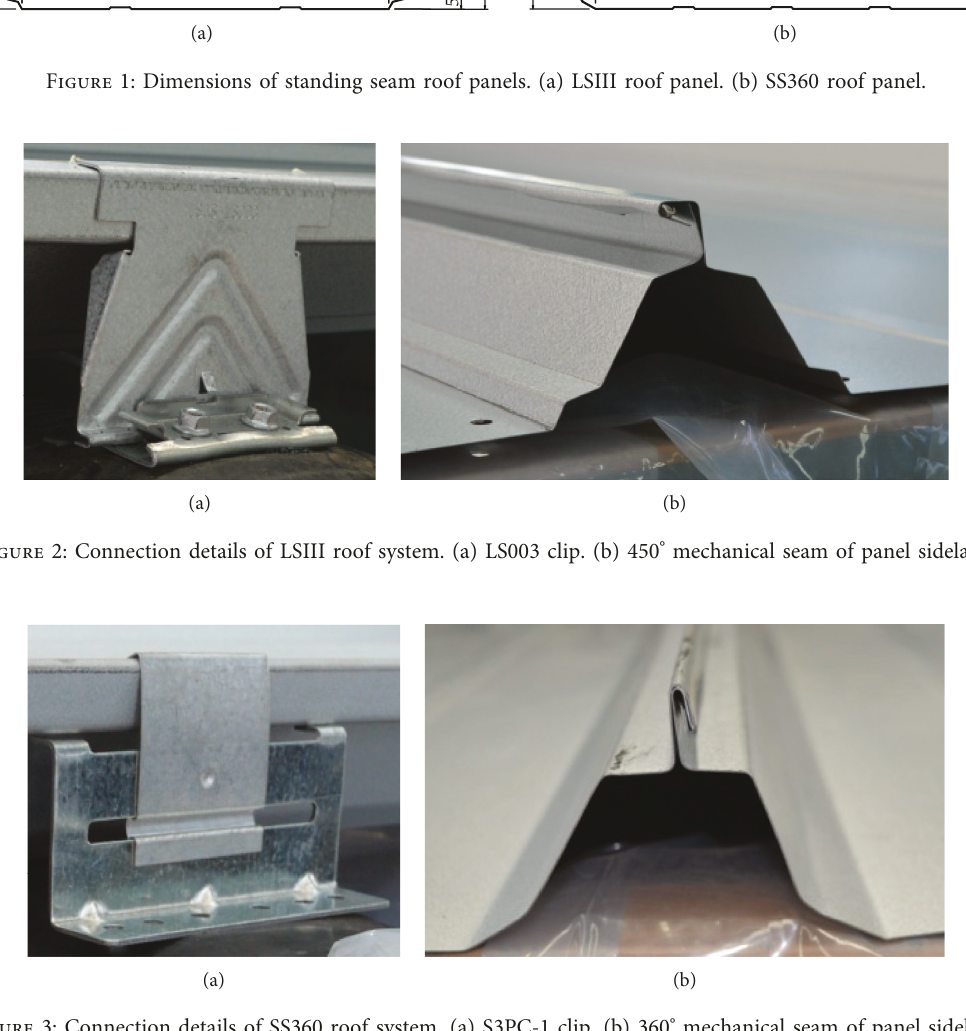
Figure 3: Connection details of SS360 roof system. (a) S3PC-1 clip. (b) 360 ° mechanical seam of panel sidelaps.